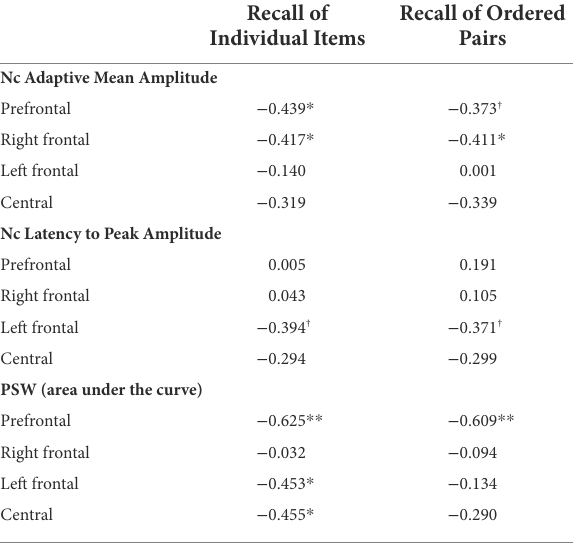
TABLE 3 Correlations between elicited imitation memory performance and ERP familiarity response (familiar-unfamiliar) at the end of the 9-month intervention ( n =